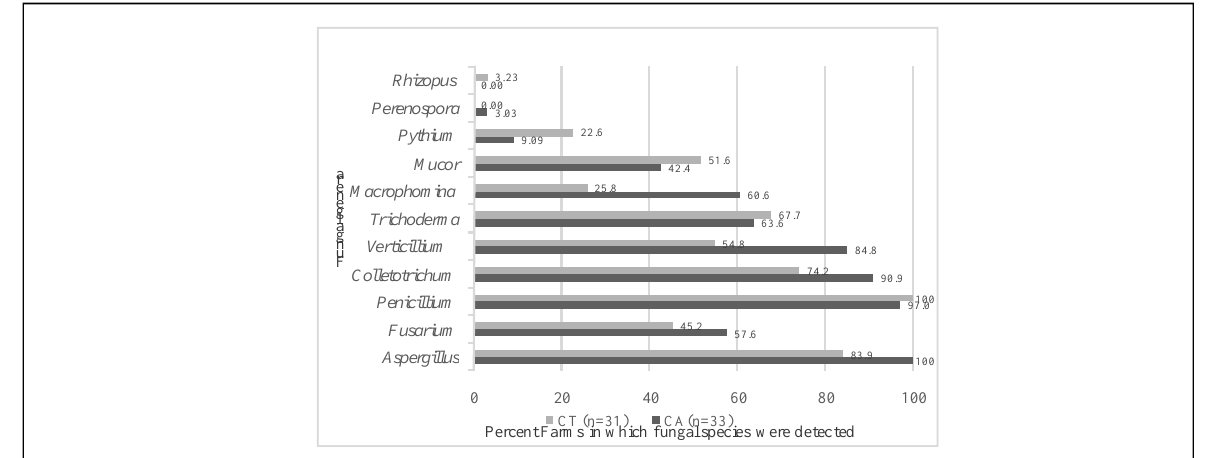
6.2. Effect of tillage method on the prevalence of different fungal genera on trial farms Results were subjected to both descriptive and inferential statistical analysis. The frequency of detection of the different fungal species on the trial farms is shown on Figure 4. Aspergillus was detected on all farms that tested CA and Penicillium on all farms that tested CT. Rhizopus was not detected on farms that tested CA in LM 4 and UM 3 respectively while Perenospora was not detected on the farms that tested CT in LM 4. Chi-square analysis on the frequency of detection of fungal species showed that only Macrophomina was statistically significantly different between CA and CT at p = 0.05.There was no difference in prevalence between CA and CT for the other fungal species. The mean populations of fungal species in CA and CT trial farms was analyzed (Table 2). The trend was that total fungal species were higher in CA than CT and in UM 3 than LM 4. The CA trial farms resulted in increase in total soil fungal population from 39.4 x 10 4 in CT-UM 3 to 61.5 x 10 4 in CA-UM 3 and